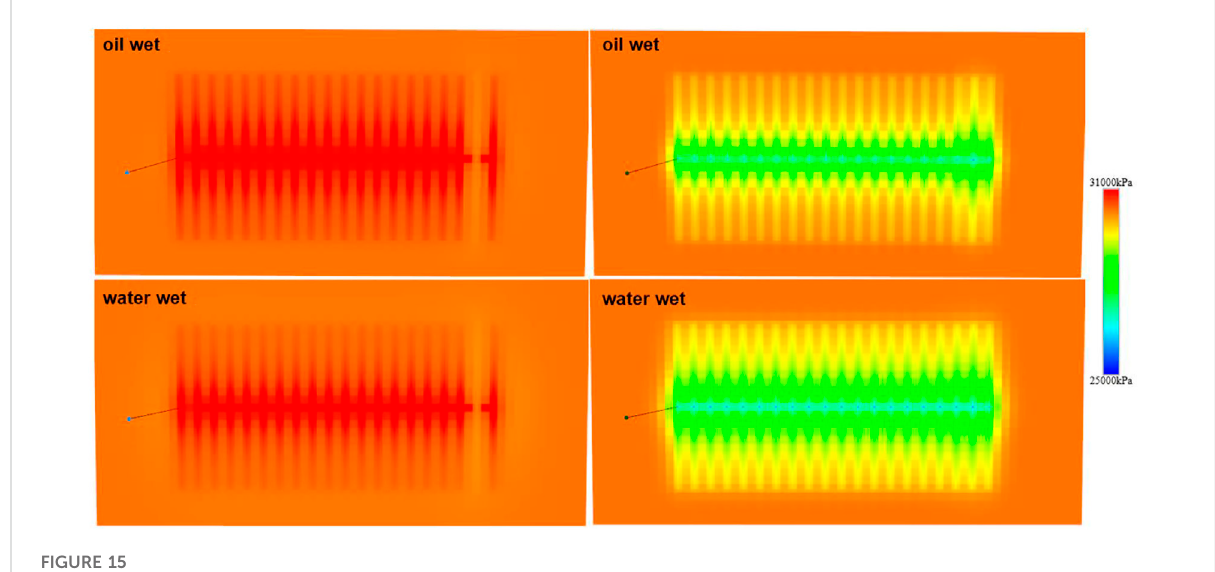
FIGURE 15 Pressure distribution in reservoirs with different wettability at the end of the second phase of water injection.